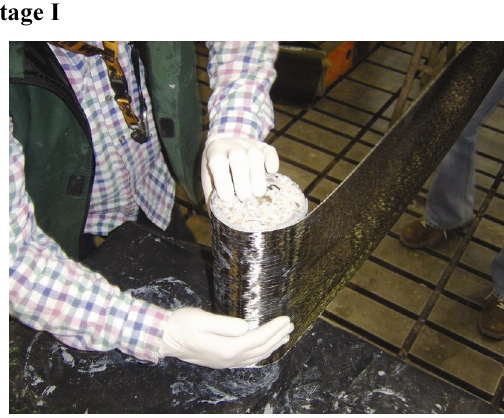
Fig. 4. Specimens preparation – stage